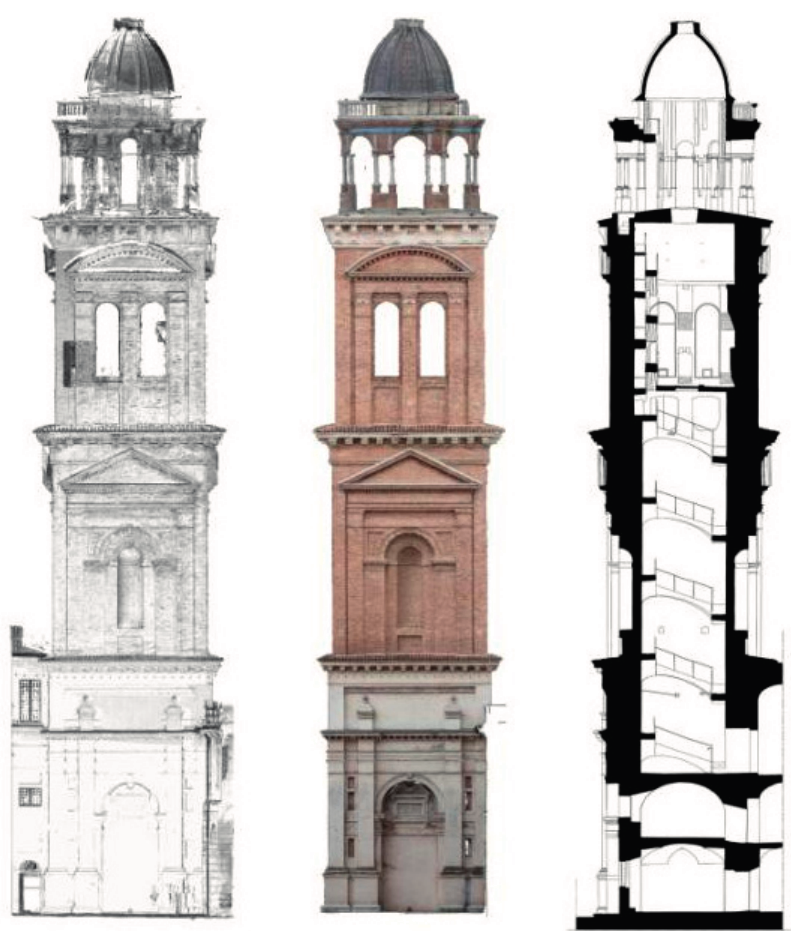
Figure 11 . Santa Barbara bell tower. Laser scanning and photogrammetry data and a final elaboration of a vertical section obtained using both the